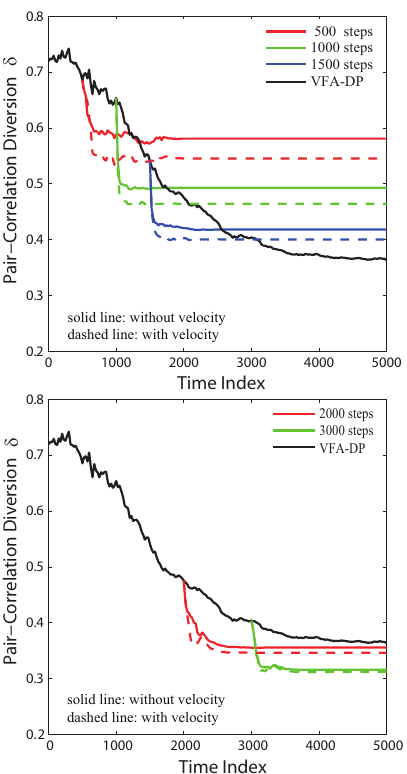
Figure 7. The PCD δ ( Ω , Ω H ) of VFA_Hybrid algorithm as a function of the time step, for the specified switching time, by taking into account the influence of node velocity when hybrid optimization transferred from VFA_DP to VFA_LJ.